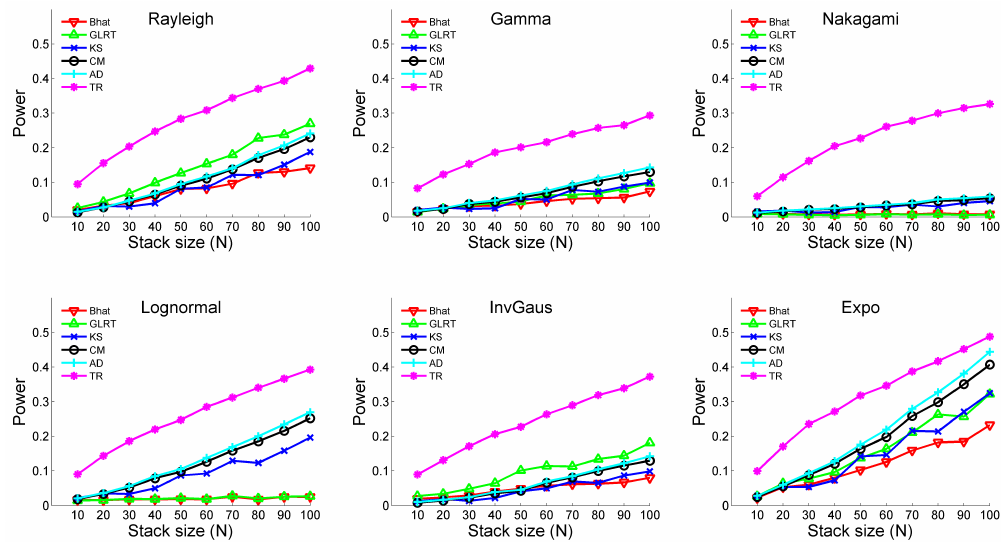
Figure 2. The power of hypothesis tests in case (i).